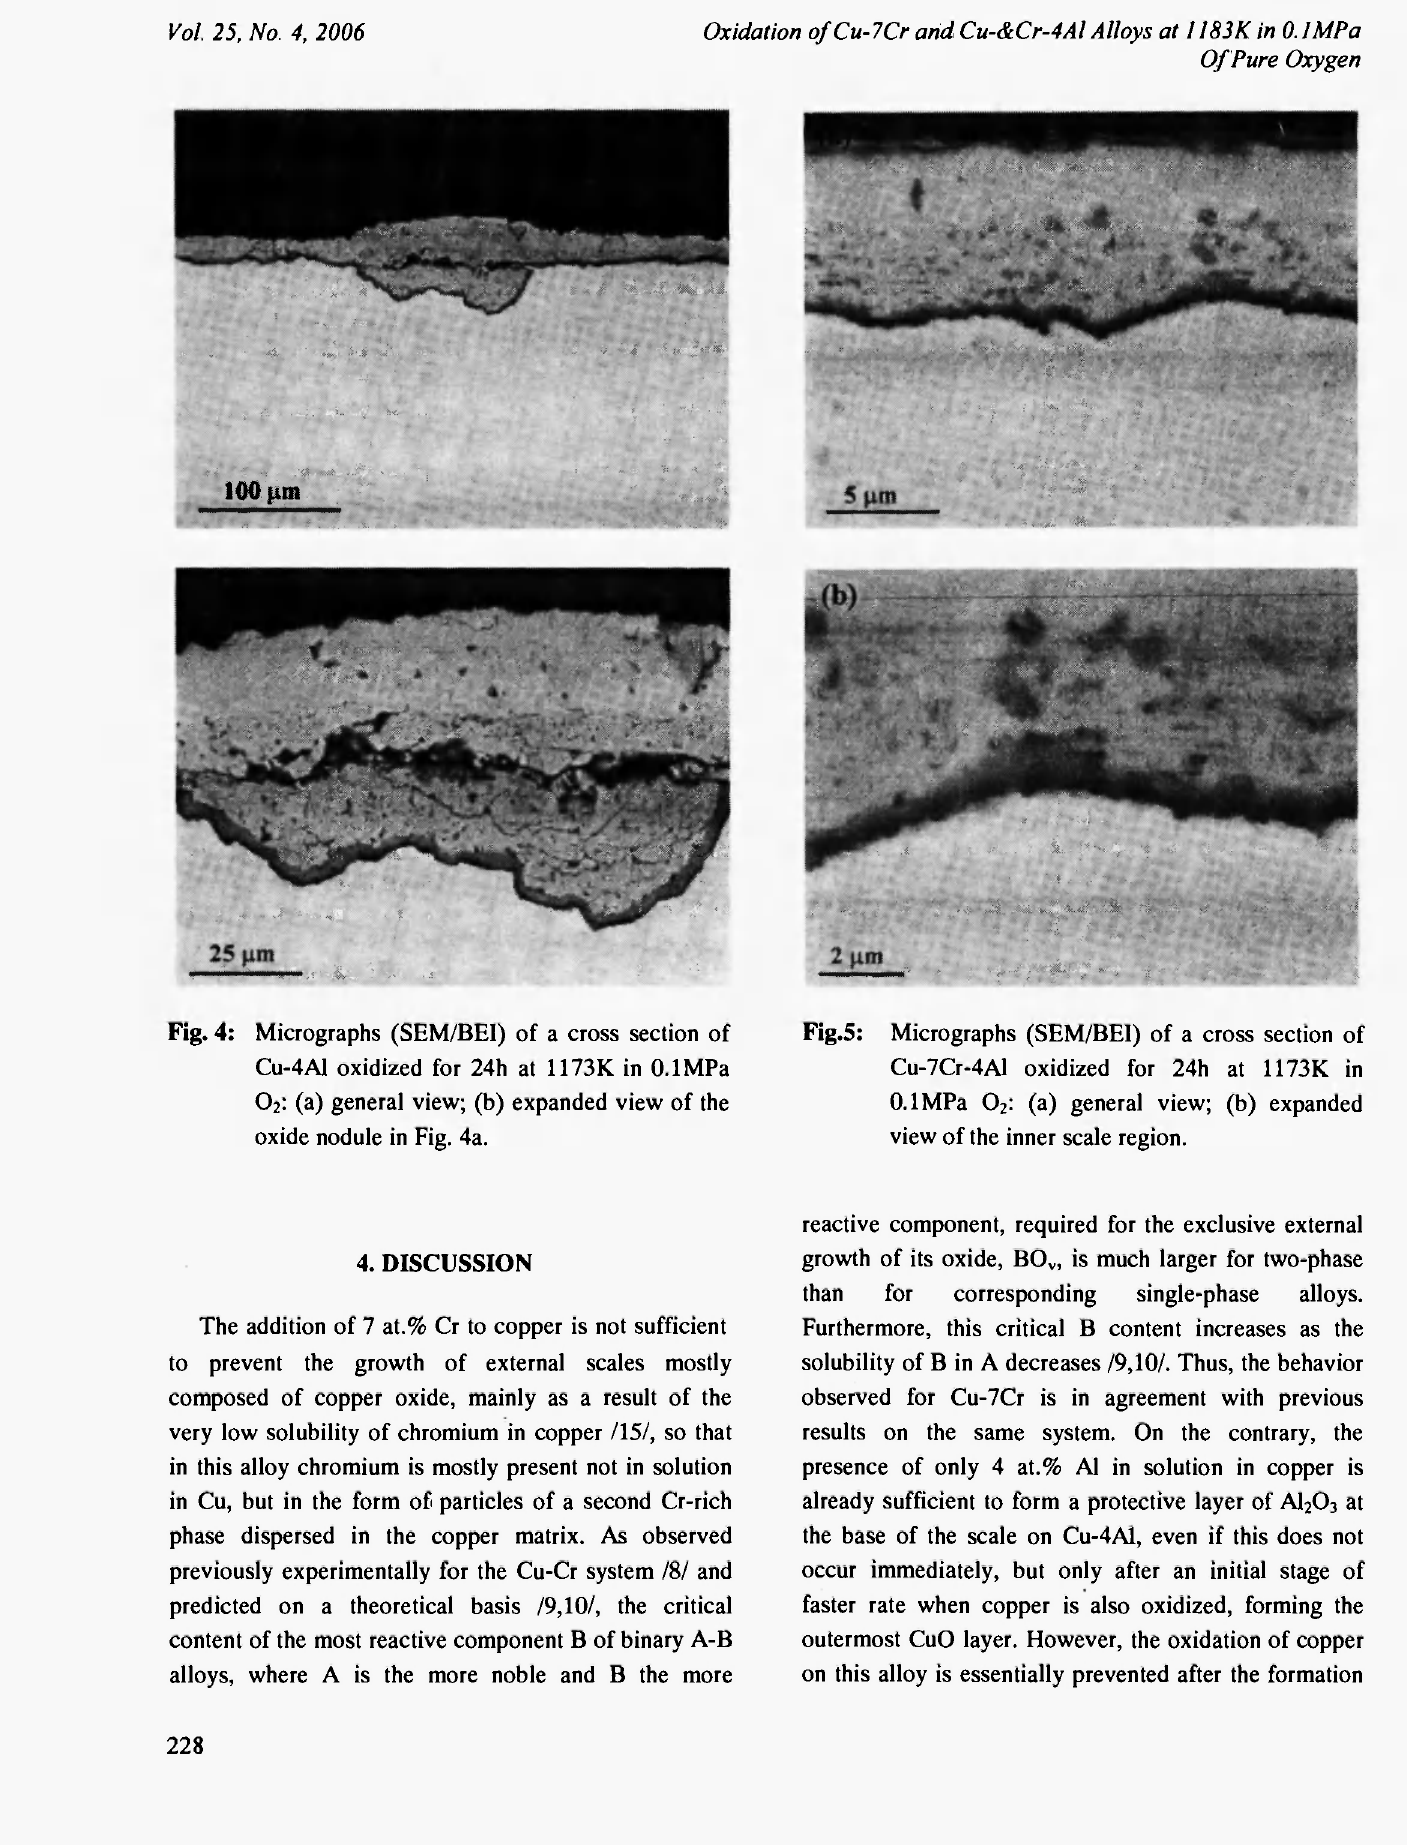
Fig.5: Micrographs (SEM/BEI) of a cross section of Cu-7Cr-4Al oxidized for 24h at 1173K in 0.1 MPa 0 2 : (a) general view; (b) expanded view of the inner scale